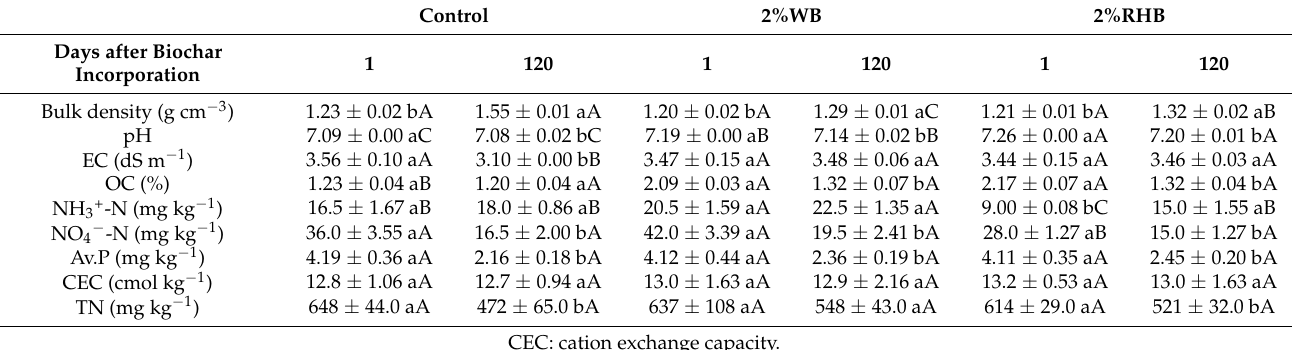
Table 2. Comparison of soil properties on various incubation days.